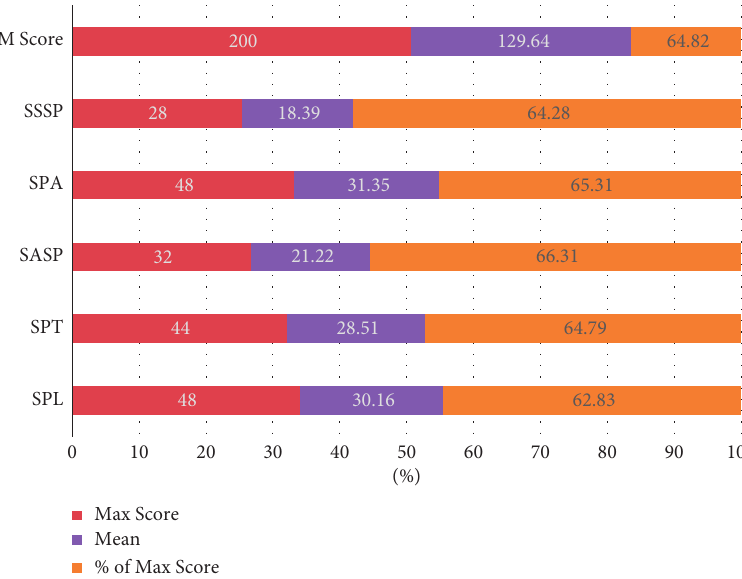
Figure 1: Diagram showing the comparisons between maximum achievable scores in the DREEM questionnaire and actual achieved scores in five domains.